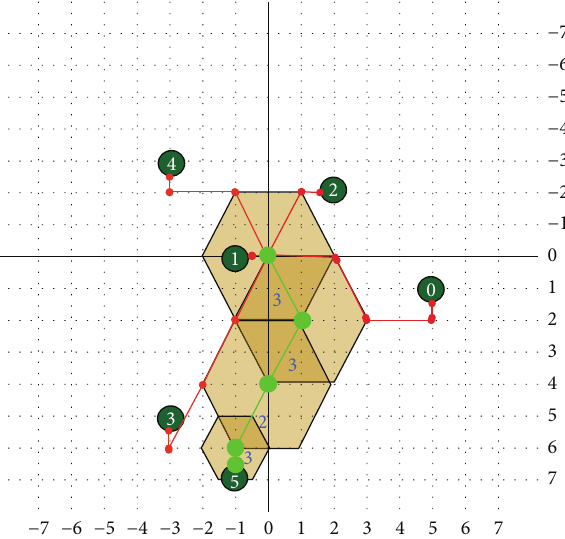
Figure 17: Some examples of selecting chromosomes.